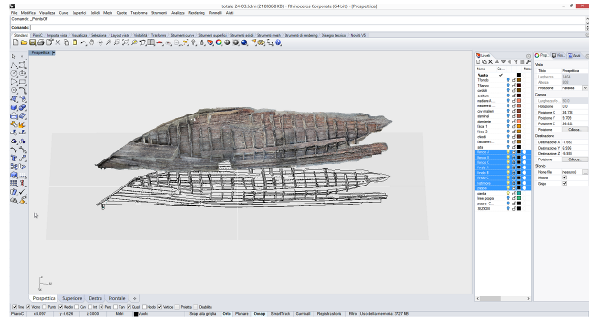
Figure 16. Projection of the textured mesh into a plane and vectorial